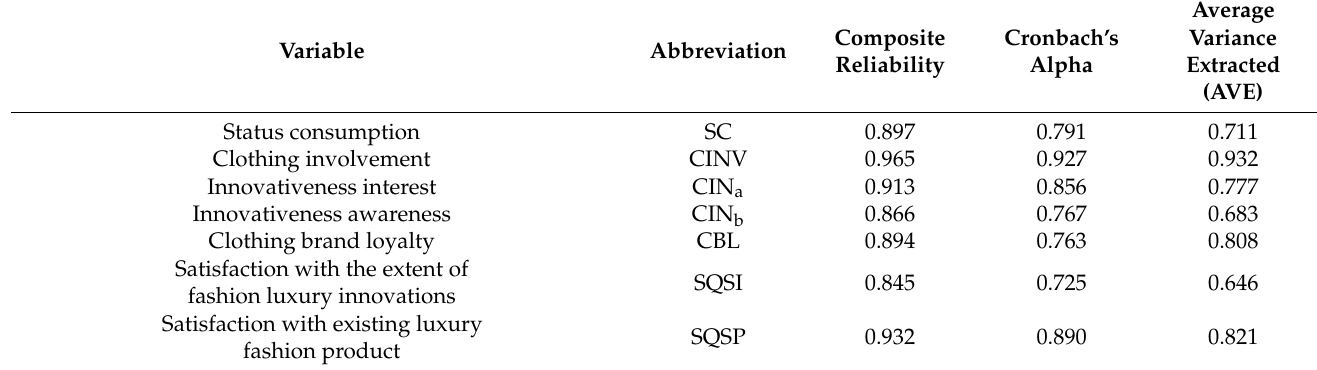
Table 6. Evaluation of the measurement model.